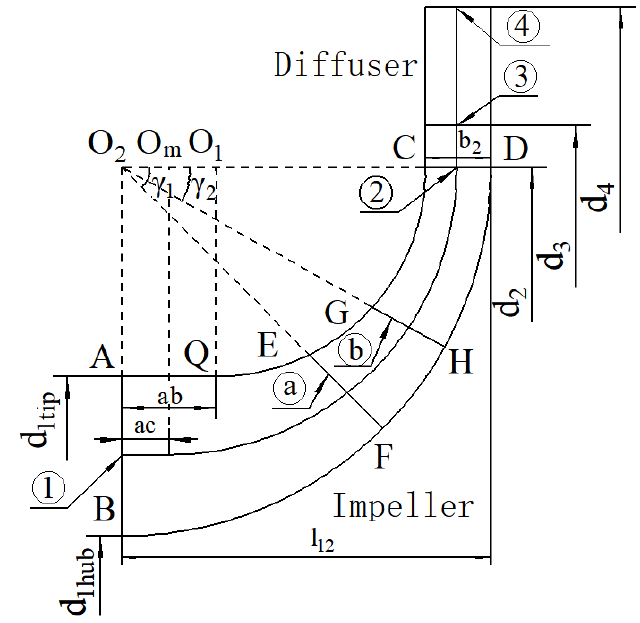
Figure 1. Meridional channel of the computational domain. As demonstrated in Figure 1, the cross-sections named as 1 (cid:13) – 4 (cid:13) in the meridional channel represent the impeller inlet, impeller outlet, diffuser inlet, and diffuser outlet, respectively. Meanwhile, each line for the hub, shroud and meanline are composed of a circular arc with O 2 , O 1 and O m as the center and corresponding to line connection. Geometric parameters that should be provided for calculations contain the blade inlet shroud diameter d 1 tip , blade hub diameter d 1 hub , impeller axial distance l 12 , impeller blade outlet width b 2 , and outlet diameter d 2 . All the other geometric parameters required can be obtained based on parameters such as the throat area and meridian area of the impeller and are used for subsequent aerodynamic calculations. As shown in Figure 2, impellers with different types of splitter blade rows can be distinguished according to the relationship between the number of inlet blades Z i 1 and the number of outlet blades Z i 2 .